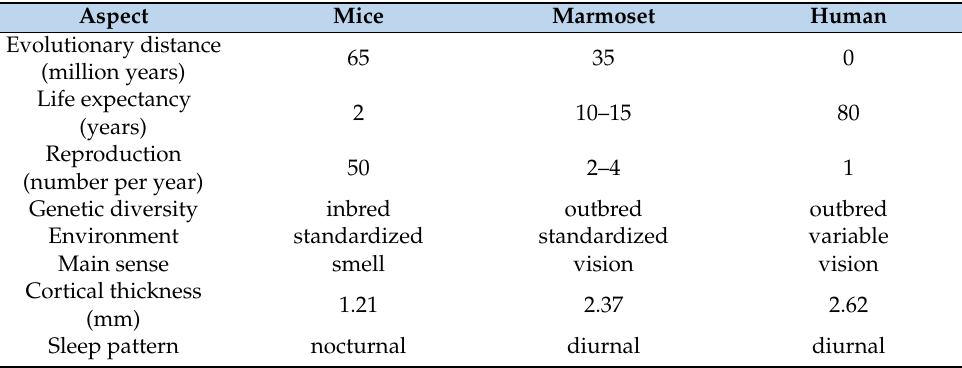
Table 1. Different aspects between rodents (mice), marmoset, and